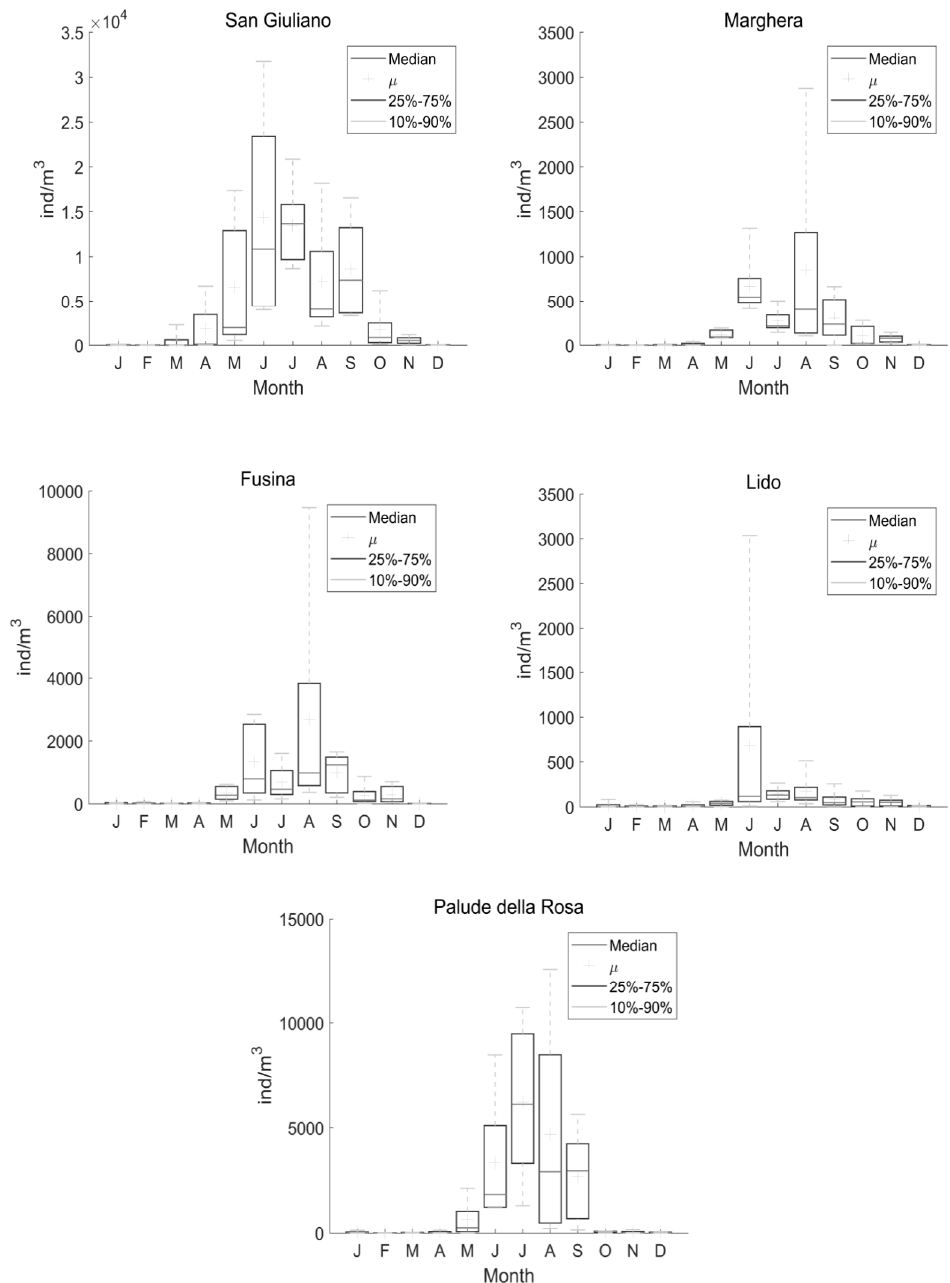
Figure 2. Box plot of monthly A. tonsa abundance from the dataset 1997–2002 for the five sampled stations (San Giuliano, Marghera, Fusina, Lido, and Palude della Rosa). The cross ( µ ) indicates the average, 25–75% indicates the interquartile range, and 10–90% indicates the interdecile range.